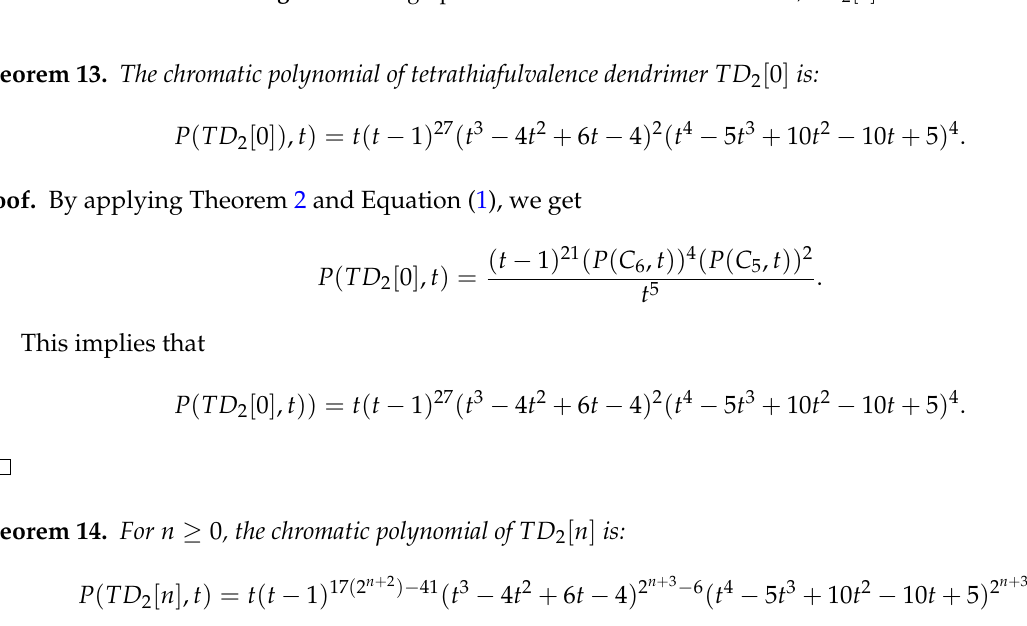
Figure 12. The graph of Tetrathiafulvalence dendrimer, TD 2 [ 1 ]